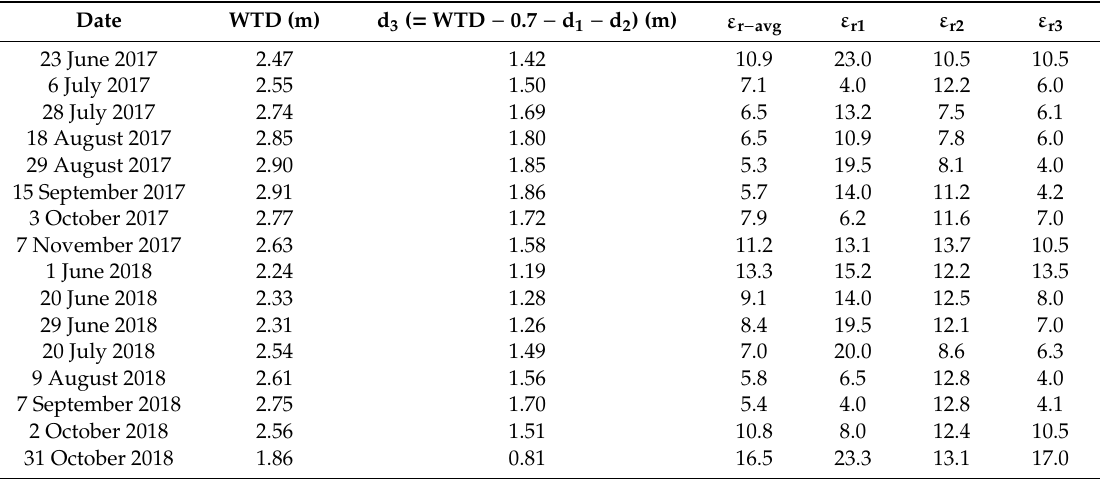
Table 4. Assumed depth of unsaturated sandy layer (d 3 ), and calculated relative